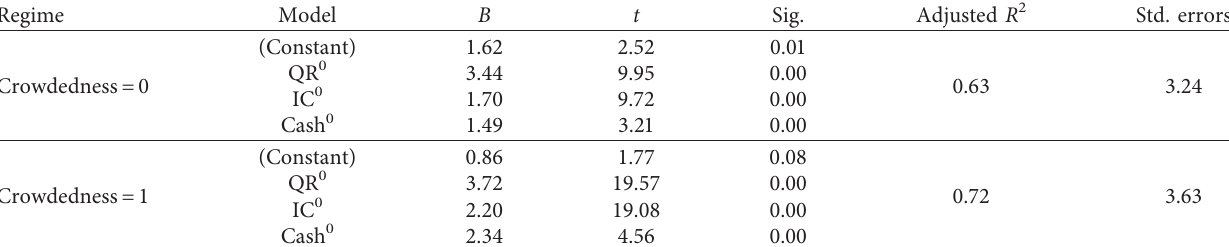
Table 2: First-choice-based BST regression